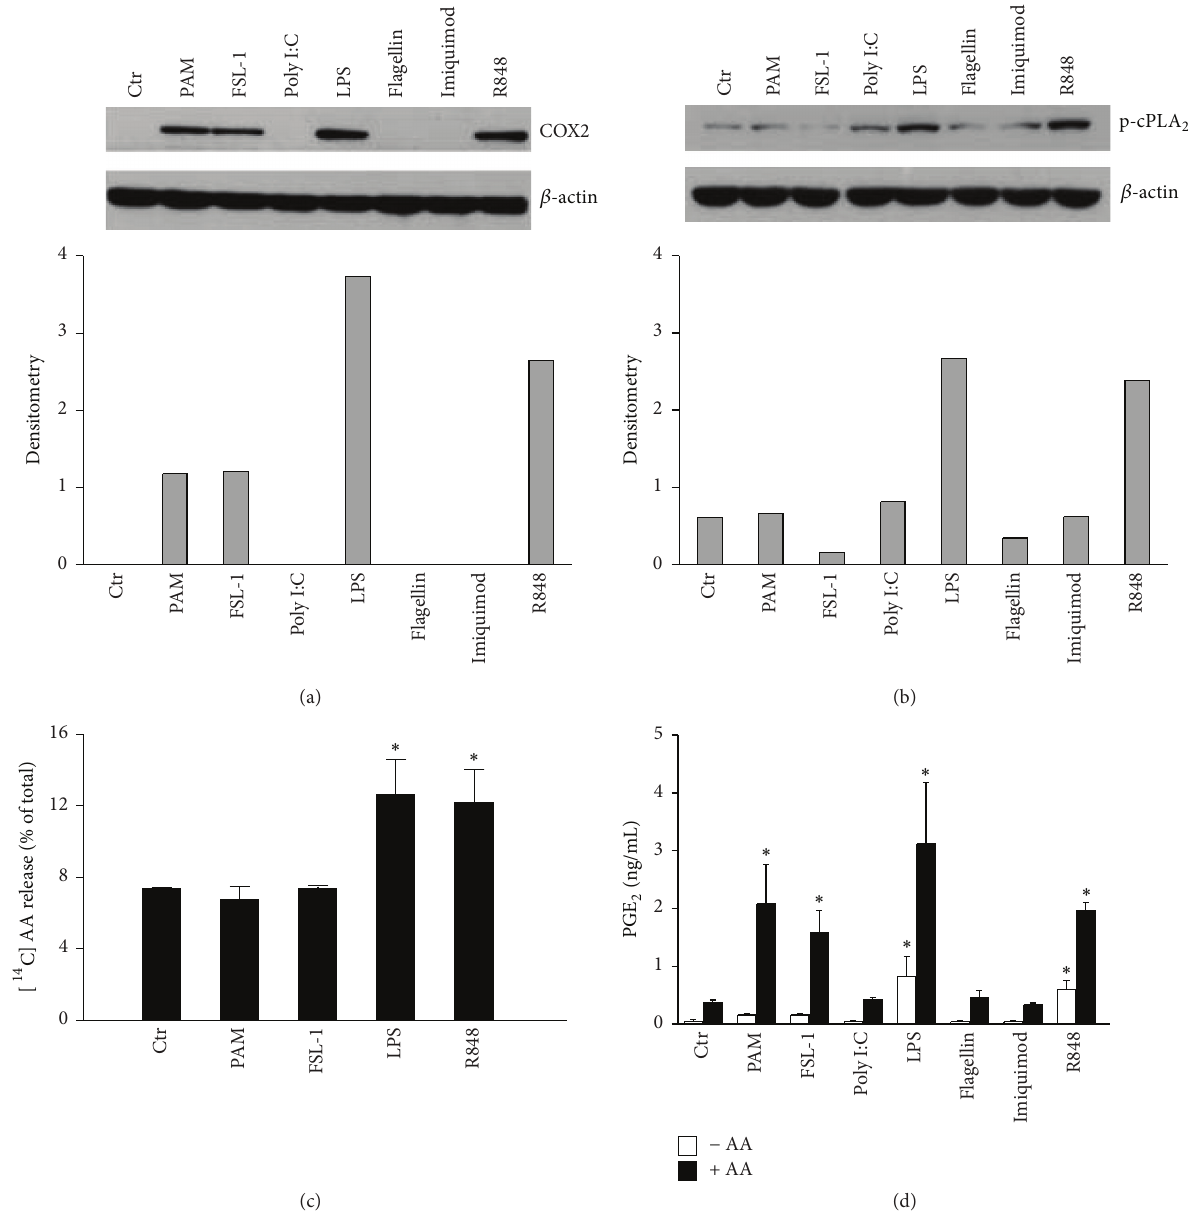
Figure 4: Lack of AA mobilization blocks the release of PGE 2 upon TLR1/2 and TLR2/6 stimulation. (a) DCs were stimulated with TLR agonists for 24 h. The expression of COX2 and 𝛽 -actin was determined by Western blot. Fluorogram from one out of 3 representative donors and its densitometric analysis are shown. (b) DCs were stimulated with TLR agonists for 30 min and the phosphorylation of cPLA 2 was determined by immunoblot. One out of 3 representative donors and its densitometric analysis are shown. (c) DCs were labelled with 0.125 𝜇 Ci/mL [ 14 C] AA overnight and then stimulated with the indicated TLR ligands for 3 h. The results are expressed as the means ± SEM ( 𝑛 = 3 ) of the percentage of [ 14 C] AA release on the total radioactivity recovered from each stimulation; ∗ 𝑃 < 0.05 by one-way ANOVA with Dunnett’s post hoc test. (d) DCs were incubated with TLR ligands in the presence (black bars) or absence (white bars) of 10 𝜇 M AA. After 24 h, supernatants were collected and the production of PGE 2 was evaluated by EIA. Results are expressed as mean ± SEM ( 𝑛 = 3 ); ∗ 𝑃 < 0.05 by one-way ANOVA with Dunnett’s post hoc